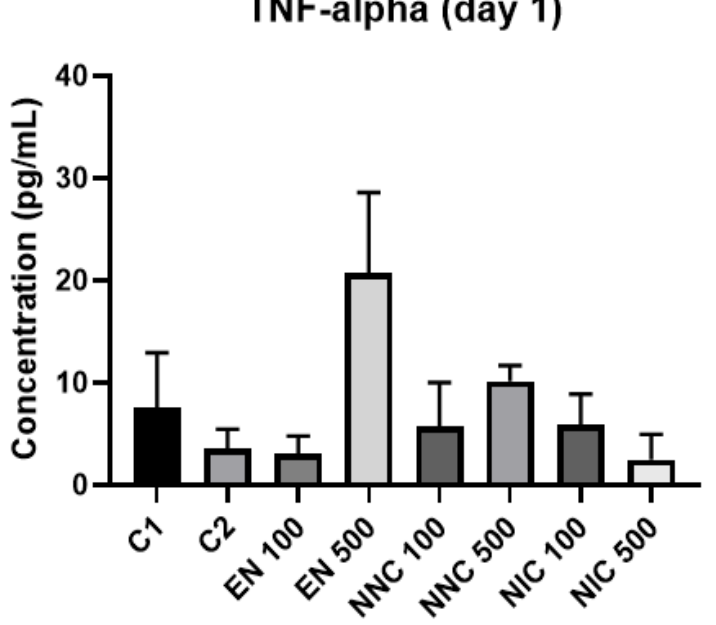
Figure 12. TNF- α detection one day after treatment with nanocapsules. C1 = control cells with no nanocapsule treatment and no LPS stimulus; C2 = control cells stimulated with LPS but no nanocapsule treatment.